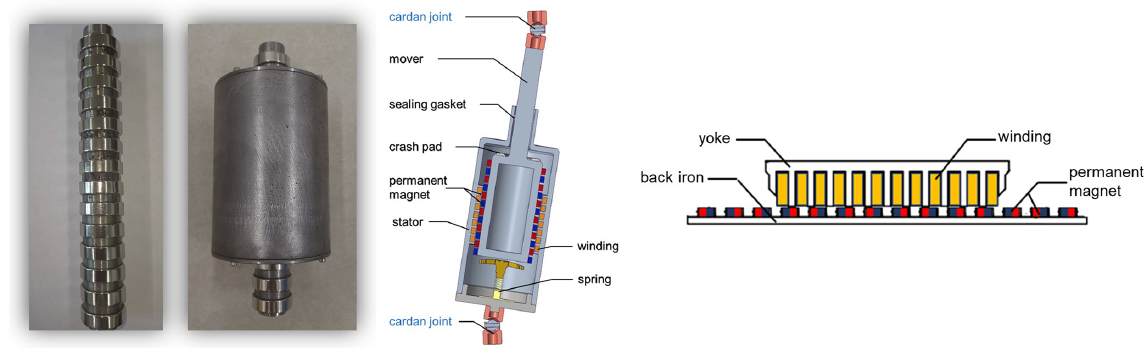
Figure 6. Linear generator prototype and internal structure